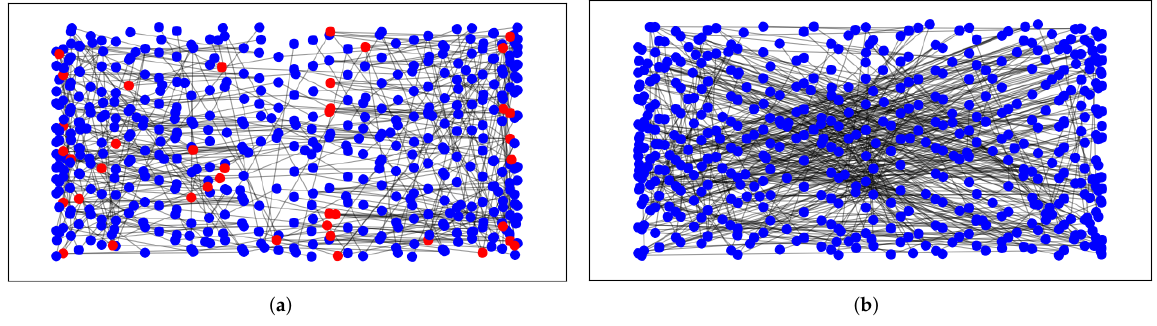
Figure 6. ( a ) MST of a 500 vertices graph. The red notes degree greater than three. ( b ) Three bounded degree spanning tree of the graph presented in ( a